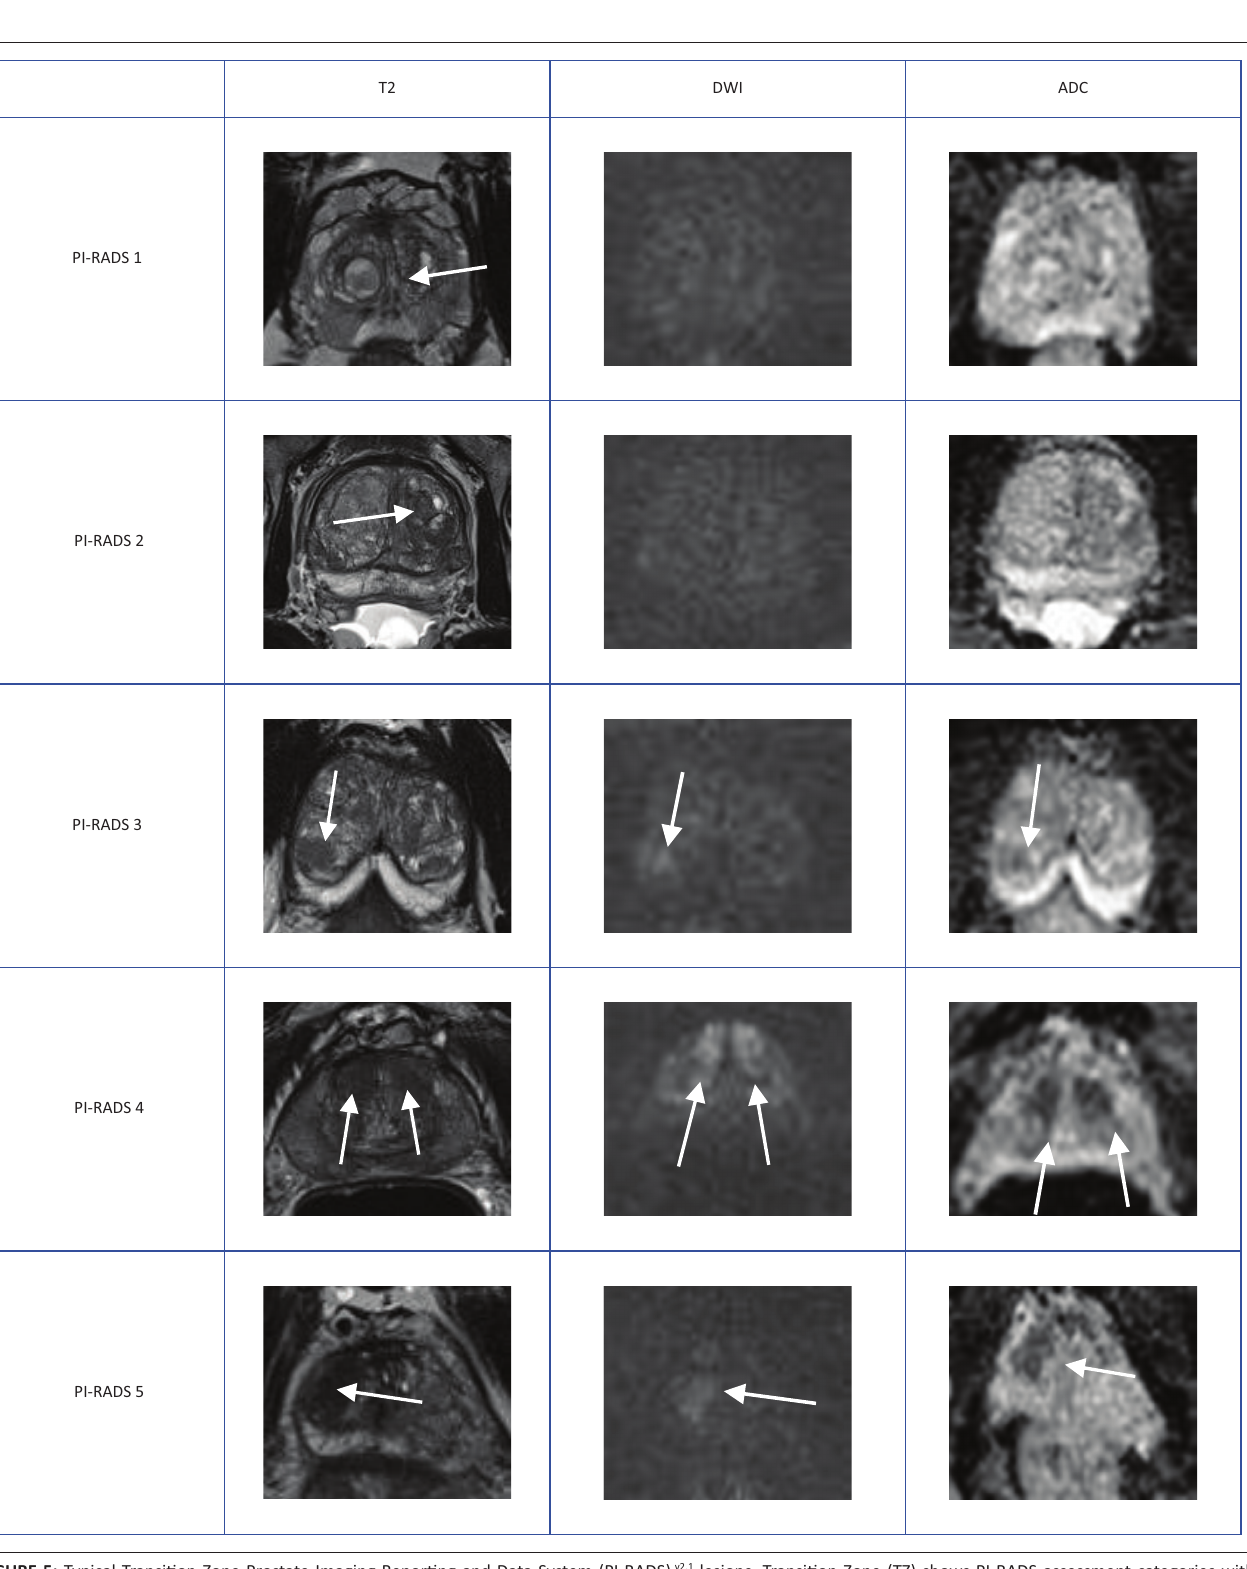
FIGURE 5: Typical Transition Zone Prostate Imaging-Reporting and Data System (PI-RADS) v2.1 lesions. Transition Zone (TZ) shows PI-RADS assessment categories with T2-weighted imaging as dominant sequence. (1) Homogeneous intermediate signal intensity OR round, completely encapsulated nodule(s), that is, ‘typical nodule’. (2) Mostly encapsulated nodule (arrow) OR homogeneous circumscribed nodule without encapsulation OR homogeneous mildly hypointense area between nodules. (3) Heterogeneous, hypointense signal intensity with obscured margins. On Apparent Diffusion coefficient (ADC) map, focal (discrete and different from background) hypointense and/or focal hyperintensity on high b -value diffusion-weighted image. (4) Non-circumscribed (arrow) homogeneous moderately hypointense lesion on T2-weighted image. Must be < 1.5 cm in its greatest dimension. On ADC map, markedly hypointense and markedly hyperintense on high b -value DW image. (5) Same as (4) above but >1.5 cm in greatest dimension or extra-prostatic extension/invasive